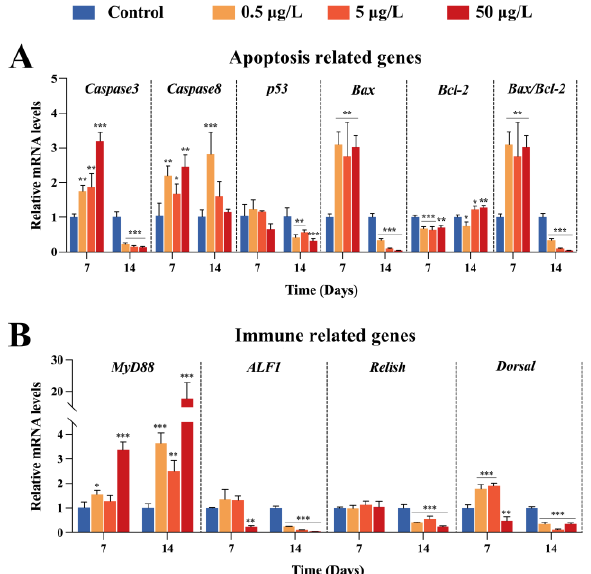
Figure 3. mRNA expression levels of apoptosis ( A ) and immune ( B )-related genes in intestine. The mRNA amounts of detected genes were normalized to the values of corresponding internal gene. The asterisks “*” indicate statistical significance compared to the control group (* p < 0.05, ** p < 0.01 and *** p < 0.001). Data are shown as mean ± SEM (n = 3).